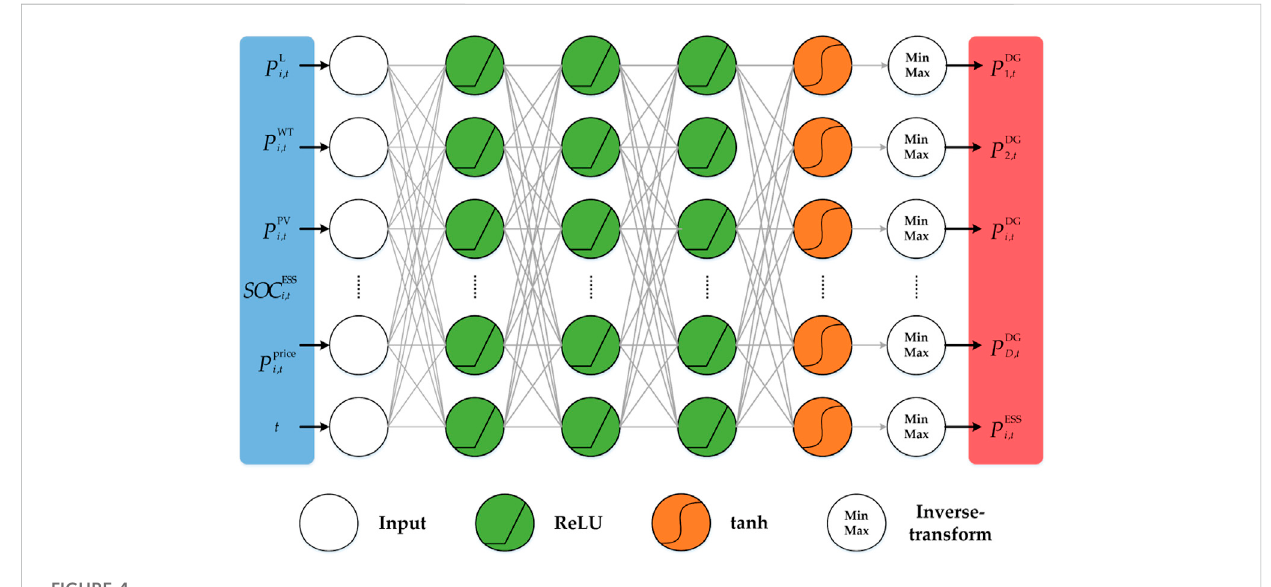
FIGURE 4 Architecture of the designed policy network.